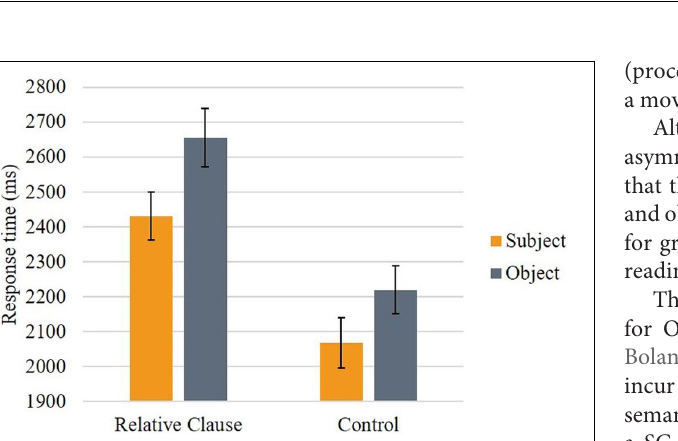
FIGURE 3 | Mean proportion of correct responses by control verb (bars represent 95% confidence interval).